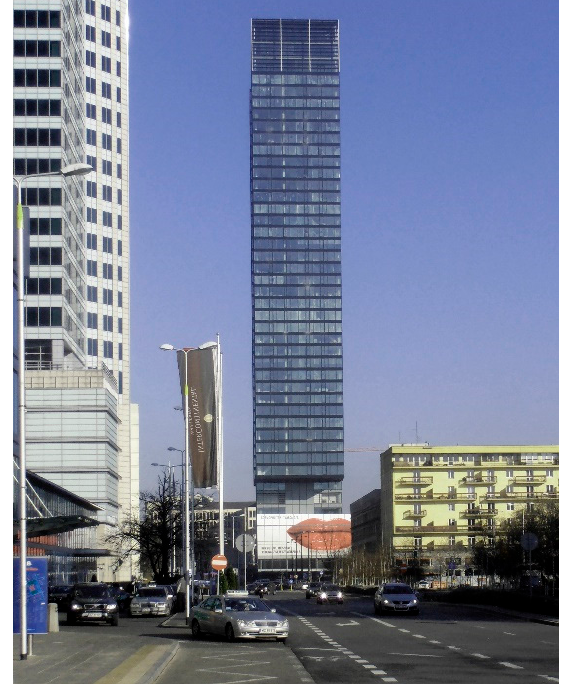
Figure 3. Cosmopolitan Tower. Source: author’s study.